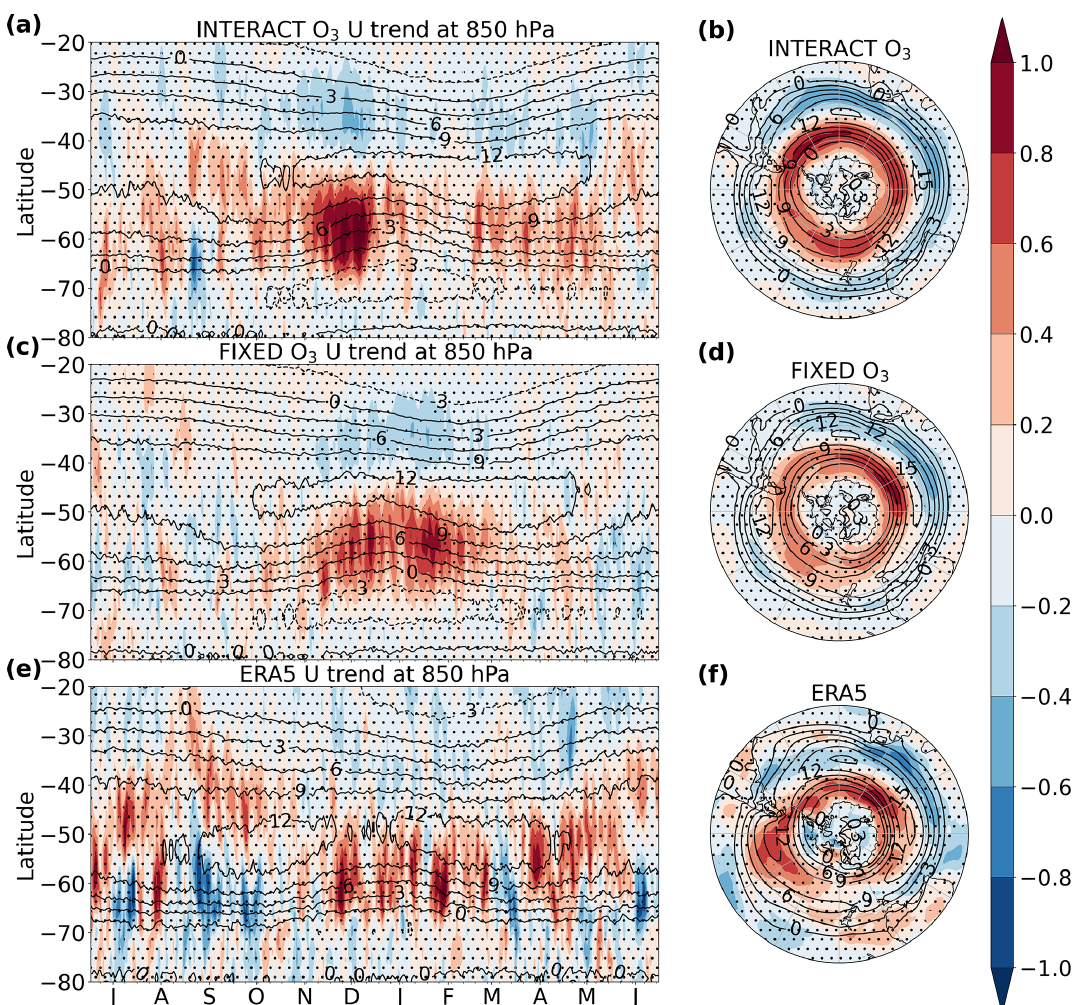
Figure 11. Seasonal cycle (a, c, e) and December–January polar stereographic maps (b, d, f) of the 850hPa zonal wind trend (ms − 1 per decade) in INTERACT O 3 (a, b) , FIXED O 3 (c, d) , and ERA5 (e, f) for the period 1958–2002 (color shading). Stippling masks regions where the trends are not significant at the 95% confidence level. The overlaying contours show the corresponding climatologies for 1958–2002. The letter corresponding to each month marks the middle of that